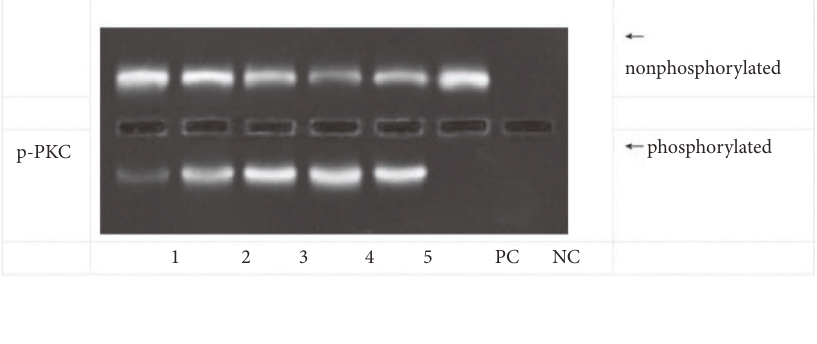
nonphosphorylated